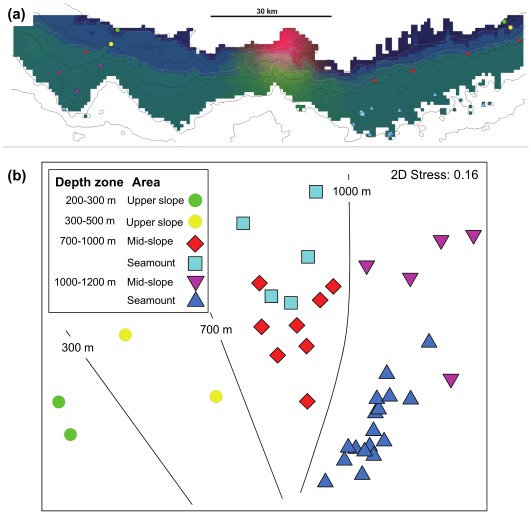
Representations of the spatial pattern in megabenthos composition on the continental margin south of Tasmania, Australia.A visualisation of showing beta-diversity (a), derived by applying multi-dimensional scaling to the compositional dissimilarities predicted by a GDM model fitted to epibenthic sled sample data (symbols) (areas of similar colours are predicted to have similar fauna composition; bathymetry contours: 200 m, 500 m, 1000 m, 1500 m, 2000 m); and (b) an MDS ordination of the Bray-Curtis dissimilarity between samples based on species abundance data, coded by bathome and margin vs seamount.